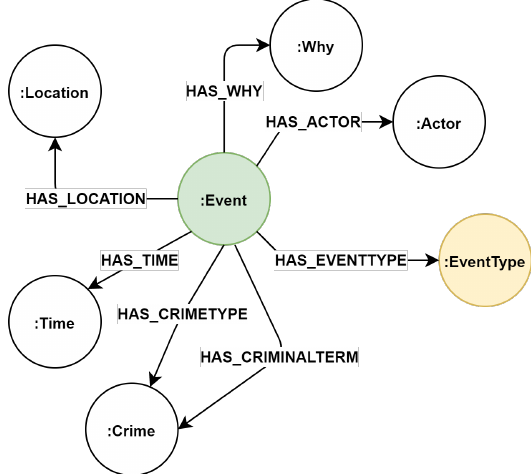
Figure 4. Modelling decisions for graph